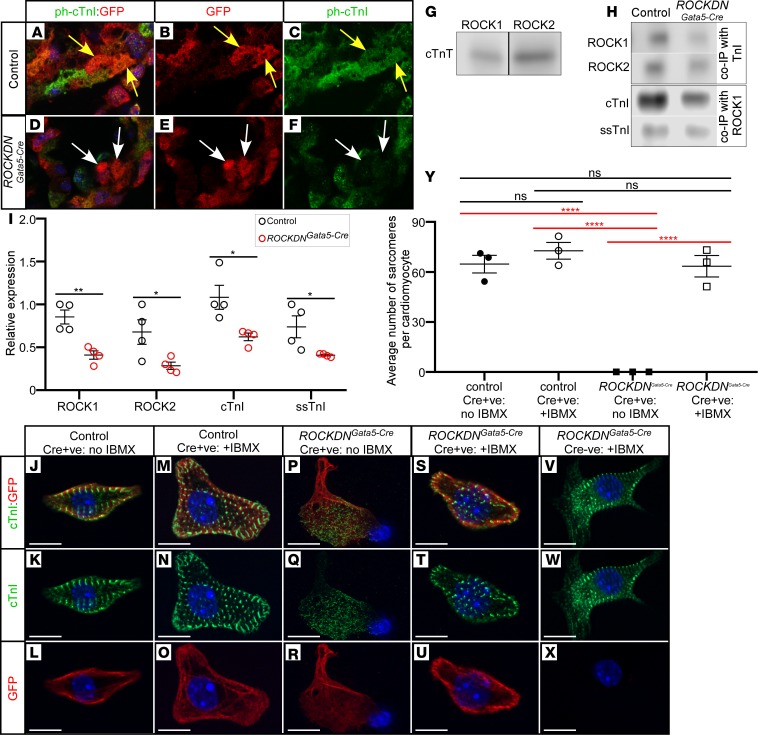
Reduction in binding between ROCK and TnI proteins may account for reduced ph-TnI expression in ROCKDNGata5-Cre mutants, and increased phosphorylation by IBMX rescues the sarcomeric phenotype in vitro.(A–C) Immunofluorescence staining of ph-cTnI (green) in Cre-activated/GFP+ cells (red staining) in cardiomyocytes of control E10.5 hearts (yellow arrows). (D–F) There was a reduction in ph-cTnI staining in Cre-activated cardiomyocytes in ROCKDNGata5-Cre hearts (white arrows) compared with control samples (yellow arrows). n = 3 for each genotype. (G and H) Co-IP using protein extracts from whole heart lysates from E16.5 embryos showed that in control hearts, ROCK1 (158kDa) and ROCK2 (161 kDa), bind to cTnT (40 kDa) (G) and to cTnI (26 kDa) and ssTnI (22 kDa) (H). (I) In ROCKDNGata5-Cre mutant hearts, there was a significant reduction in binding between the ROCK proteins and the troponin proteins. Co-IP with TnI showed a significant reduction in expression of ROCK1 and ROCK2, and conversely, in the same samples, co-IP with ROCK1 gave a significant reduction in cTnI and ssTnI expression in ROCKDNGata5-Cre mutants. n = 4 for each genotype. (J–X) Primary cardiomyocytes were cultured from E15.5 control and ROCKDNGata5-Cre mutants. GFP antibody was used to identify the Cre-activated (Cre+ve) cells (red staining), and cTnI antibody confirmed which cells were cardiomyocytes by labeling sarcomeres (green). Addition of IBMX to control cells did not have any effect (M–O). Cre-activated cardiomyocytes from ROCKDNGata5-Cre mutants, lacked sarcomeric structure (P–R). Addition of IBMX rescued the sarcomeric structure in Cre-activated cardiomyocytes from ROCKDNGata5-Cre mutants (S–U). Similar to the control samples, Cre– cells from ROCKDNGata5-Cre mutants had normal sarcomeric organization that was not altered following the addition of IBMX (V–X). (Y) The average number of sarcomeres per cardiomyocyte, from a total of 10 cells per well, was determined. There were no significant differences between control Cre+ cardiomyocytes with and without IBMX. There was a significant difference in sarcomere number between ROCKDNGata5-Cre Cre+ cardiomyocytes without IBMX compared with both control samples. Addition of IBMX to ROCKDNGata5-Cre Cre+ cardiomyocytes significantly increased sarcomeres, to a level that was no longer significantly different relative to both control groups; thus, addition of IBMX rescues the sarcomeric phenotype of ROCKDNGata5-Cre Cre+ cardiomyocytes. n = 3 for each genotype. Data are presented as mean ± SEM. *P < 0.05, **P < 0.01 by unpaired t test (I) and ****P < 0.0001 by 1-way ANOVA with Bonferroni’s correction for multiple comparisons (Y). Scale bars: 50 μm (A–F) and 10 μm (J–X).